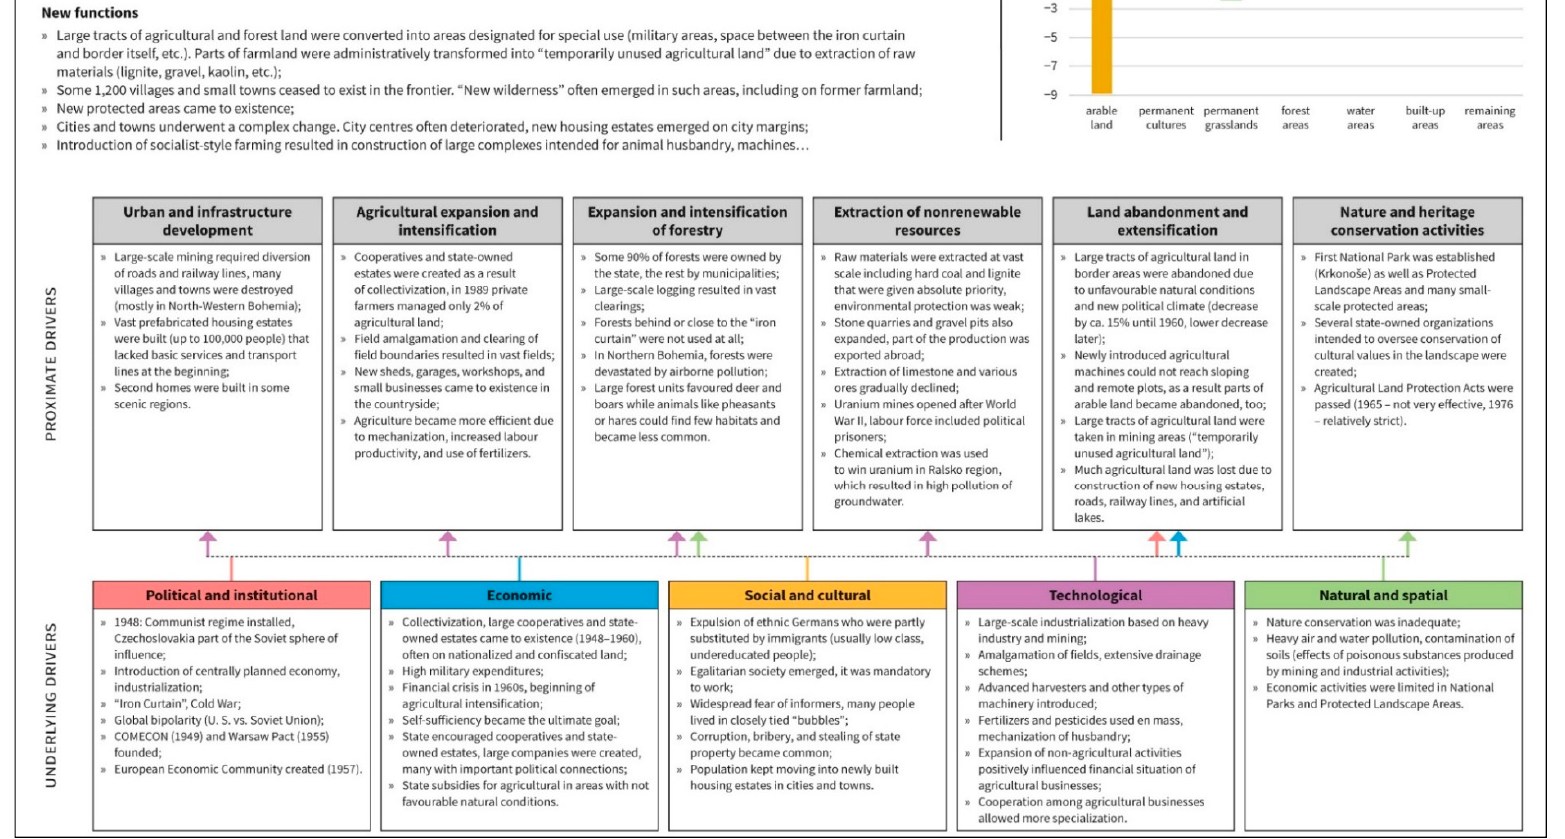
Figure A3. Underlying and Proximate Driving Forces of Landscape Change 1948–1990